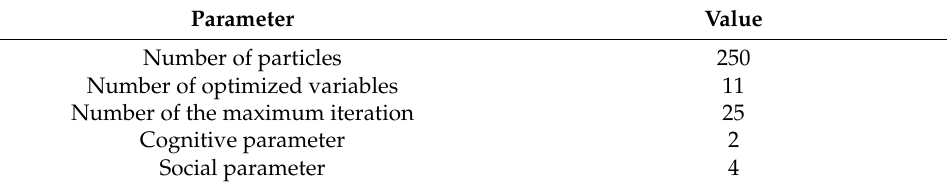
Table 3. The PSO parameters.